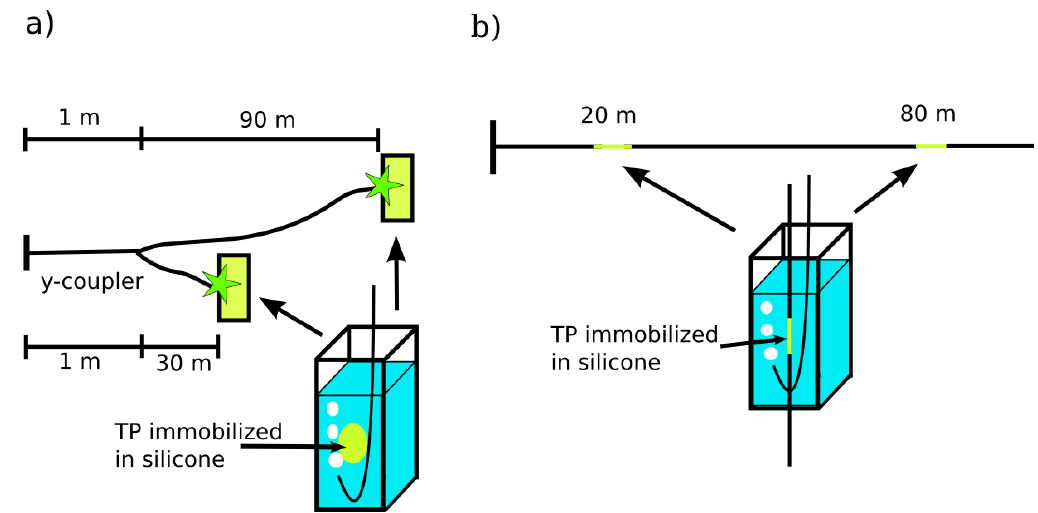
Figure 2. ( a ) Fiber arrangement of the branched fiber model. ( b ) Fiber arrangement of the single linear fiber